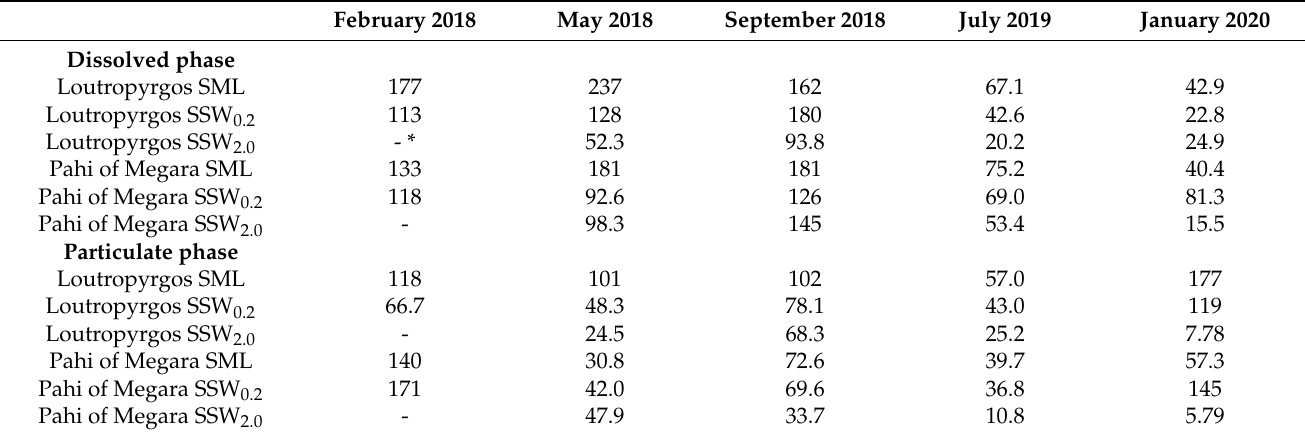
Table 2. Concentrations (ng L − 1 ) of ∑ PAHs in the dissolved and particulate phases of seawater.